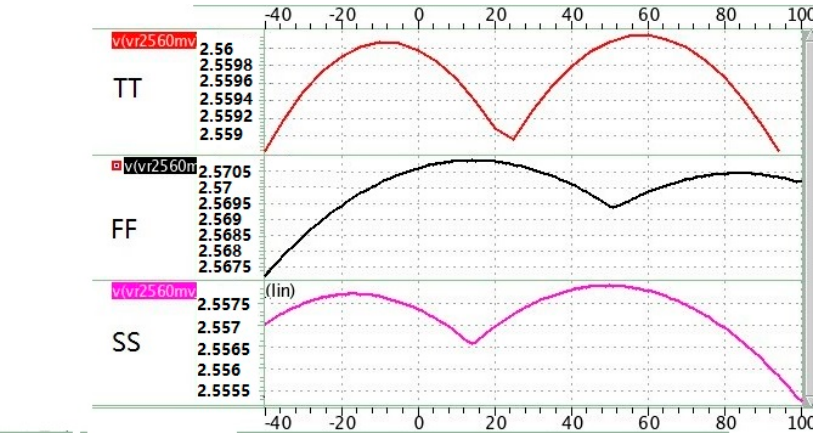
Figure 7. Simulation results of proposed SPWBGR.